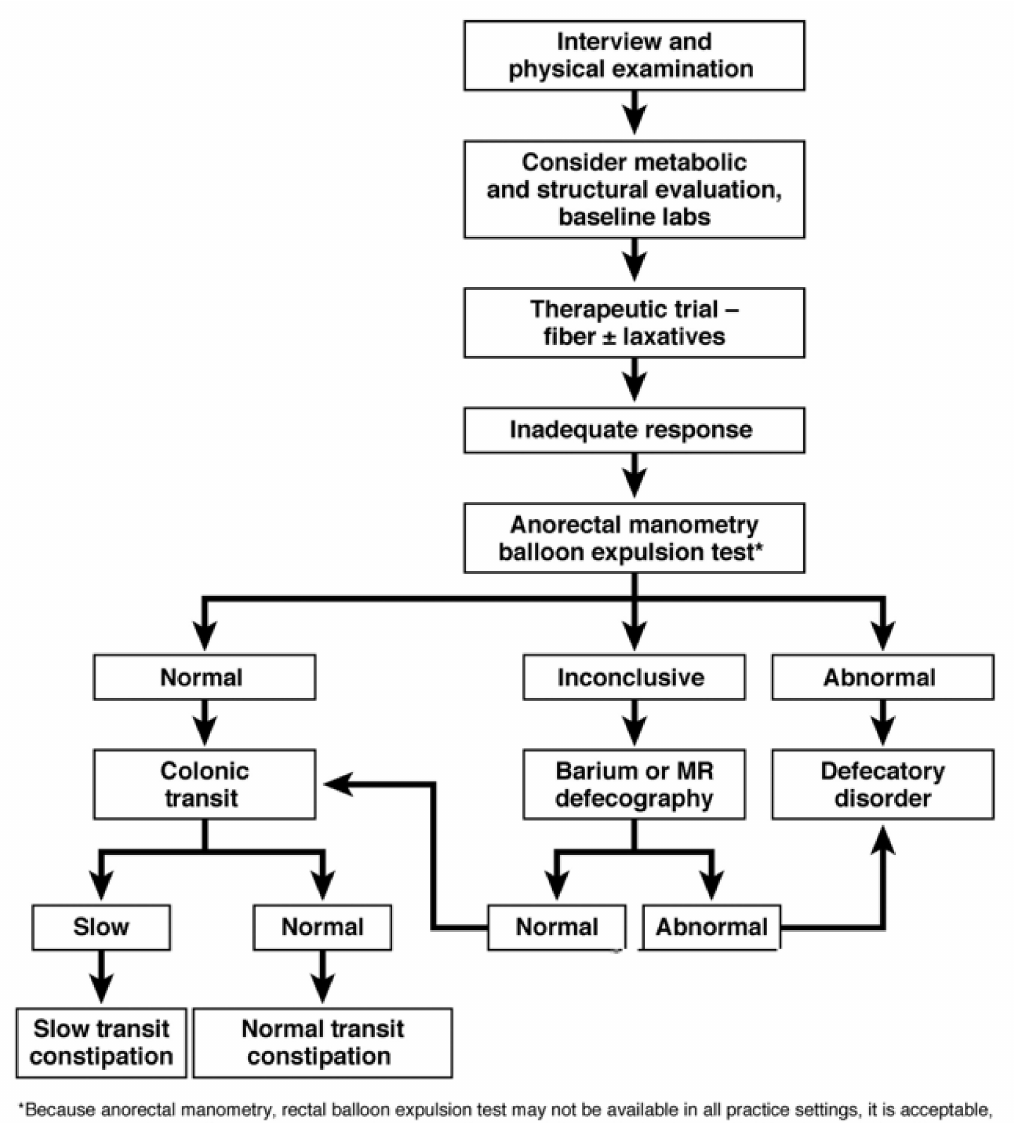
Figure 2. Diagnosing chronic constipation, Reprinted from Gastroenterology , Vol. 144, Bharucha, A.E., Dorn, S.D., Lembo, A., Pressman, A., American Gastroenterological Association Medical Position Statement on Constipation, Pages 211–217, 2013, with permission from Elsevier [28]. * As anorectal manometry/rectal balloon expulsion test may not be available in all practice settings, it is acceptable in such circumstances to proceed to assessing colonic transit with the understanding that delayed colonic transit does not exclude a defecatory disorder. MR, magnetic